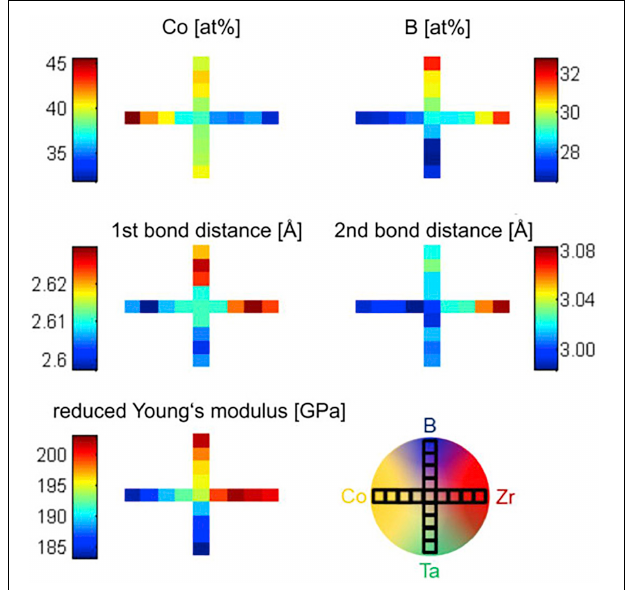
FIGURE 2 | Co and B concentration, 1 st and 2 nd bond distance and Young’s modulus along the composition gradients of a combinatorial Co-Zr-Ta-B metallic glass as sketched in the lower right scheme of a combinatorial sample. The color scheme indicates the value of the quantity shown along the respective gradients. Each box in the gradient correlates to the measurement location on the investigated sample. Reproduced from Schnabel et al. (2016b) with permission from